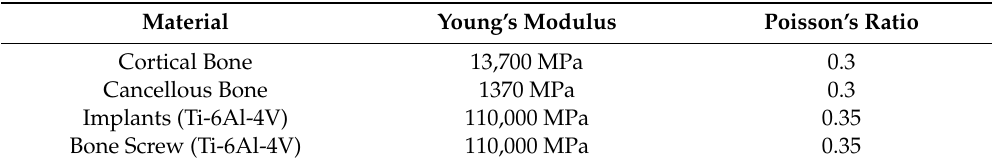
Table 1. Elastic modulus and Poisson’s ratios used in this study.